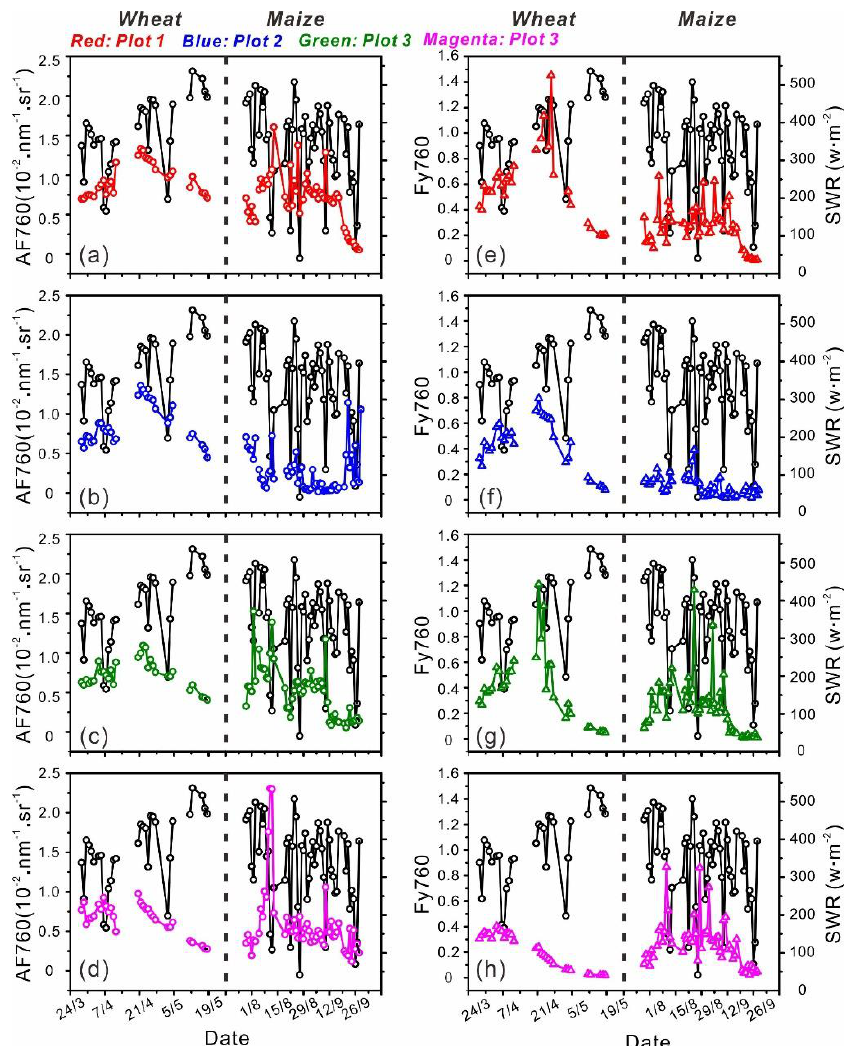
Figure 4. Seasonal patterns of daily AF760 (first column) and Fy760 (second column) from wheat (left of dashed line in each sub-figure) and maize (right of dashed line in each sub-figure) in the four plots compared with the daily solar radiation (SWR). All measurements of wheat were collected from 28 March to 19 May 2017, while the measurements of maize were collected from July 29 to September 29 of 2017.